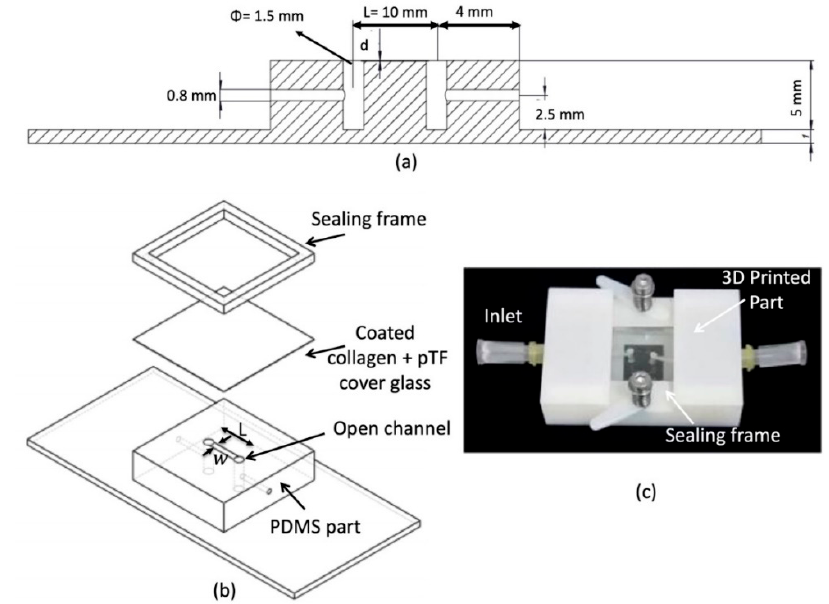
Figure 1. 3D schematics and the picture of the biomimetic microfluidic channel. ( a ) the cross-sectional view of the microfluidic channel. ( b ) 3D assembly of the different parts of the microfluidic channel. ( c ) Real image of the microfluidic channel.